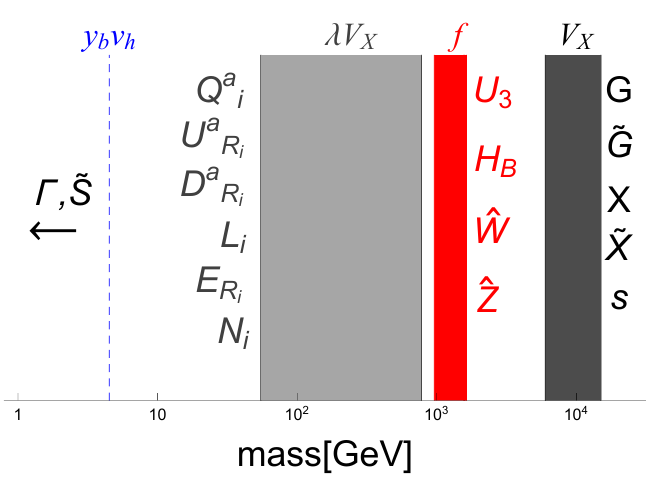
Figure 2 . A schematic of the spectrum of the theory with the field content in table 2. are combinations of dominantly ν and subdominantly D i get large masses from v ˜ and are removed from low energy theories. For sterile neutrino X masses about 10 5 MeV, we have an upper bound of the neutrino mixing angle U Y v / ( λ v ˜ ) < 10 − 2 . Therefore | Y | ≤ 10 − 2 is allowed according to all the current ν n ν h X